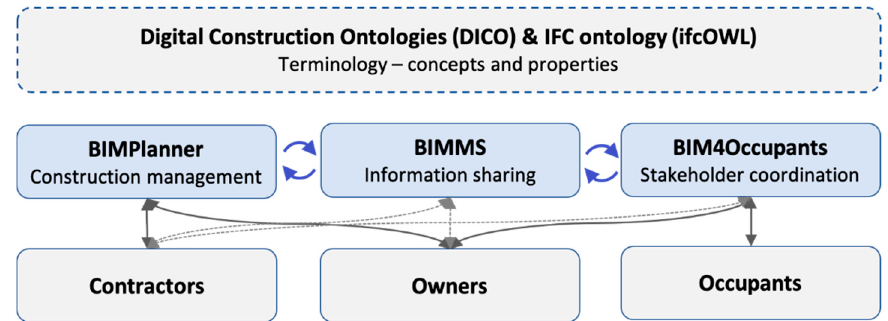
Figure 1. Information sharing between BIMPlanner and BIM4Occupants through